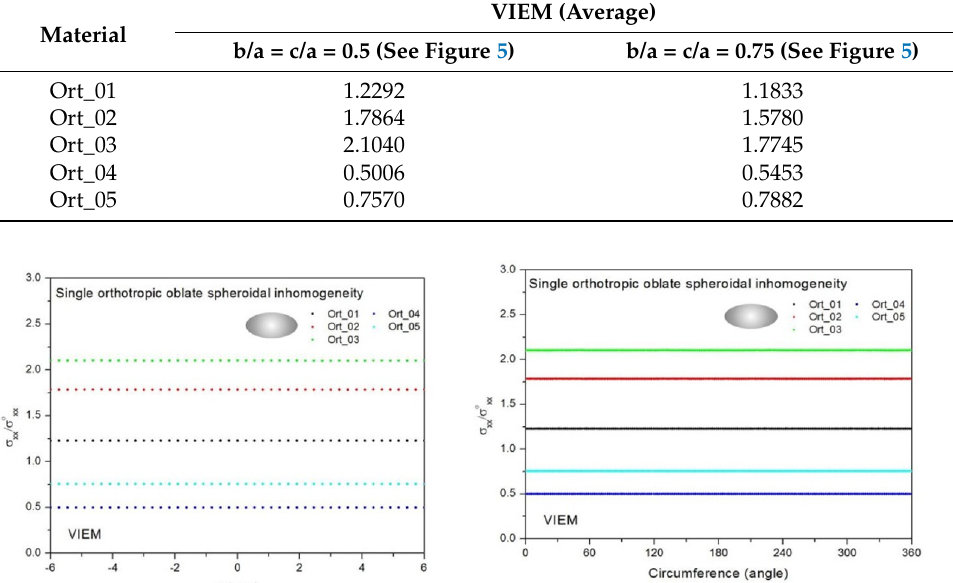
Figure 21. VIEM results for the normalized tensile stress component ( σ xx / σ oxx ) along ( left ) the x–axis inside and ( right ) the circumferential direction of the orthotropic oblate spheroidal inclusions (Ort_01, Ort_02, Ort_03, Ort_04 and Ort_05) with b/a = c/a = 0.75 (a = 6 mm) under uniform remote tensile loading.